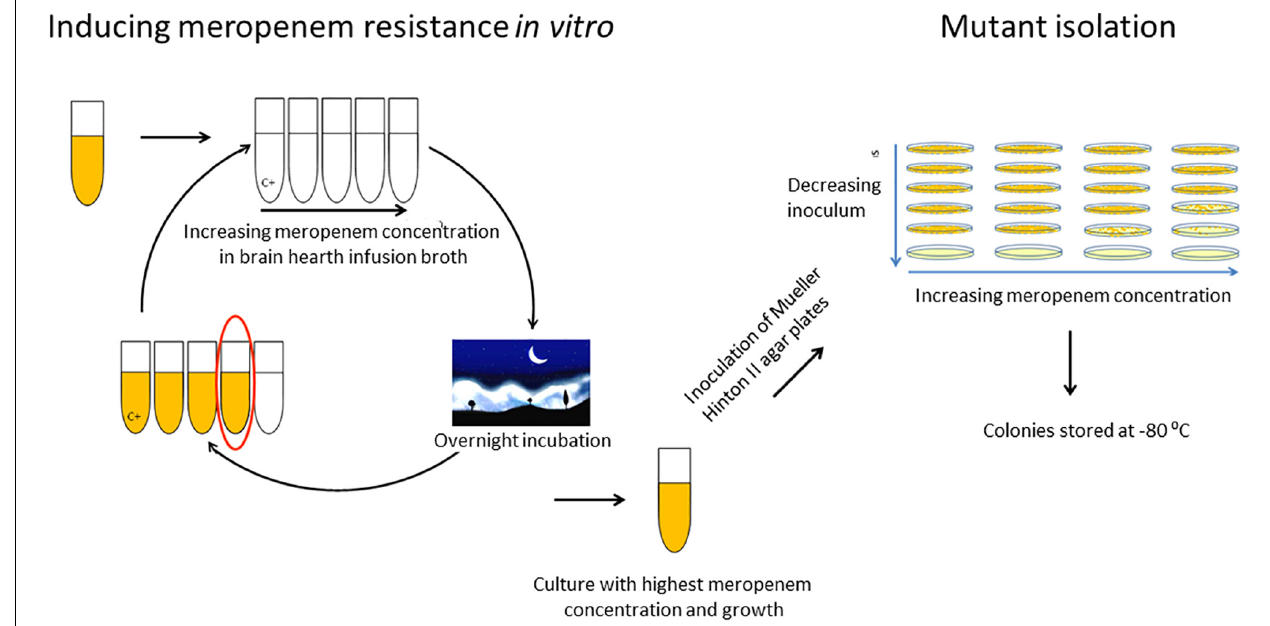
FIGURE 1 | In vitro exposure to increasing meropenem concentrations and selection of mutants.